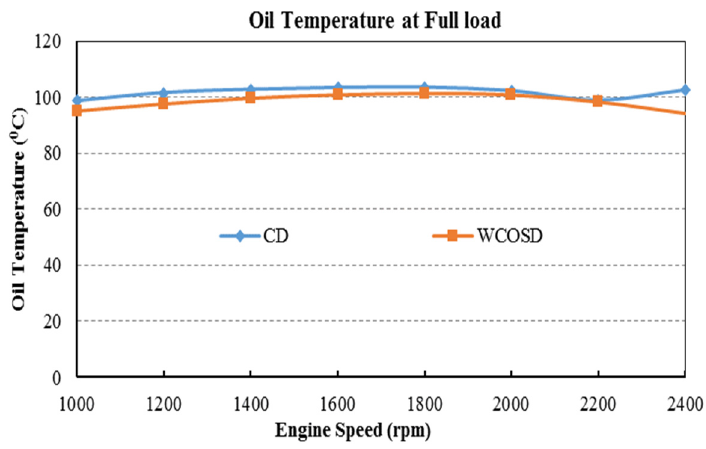
Figure 4. Lubricant oil temperature at full load condition.